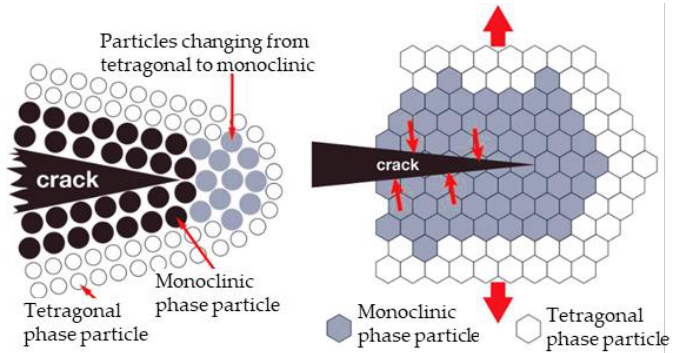
Figure 12. Transformation toughening mechanism in zirconia [29].